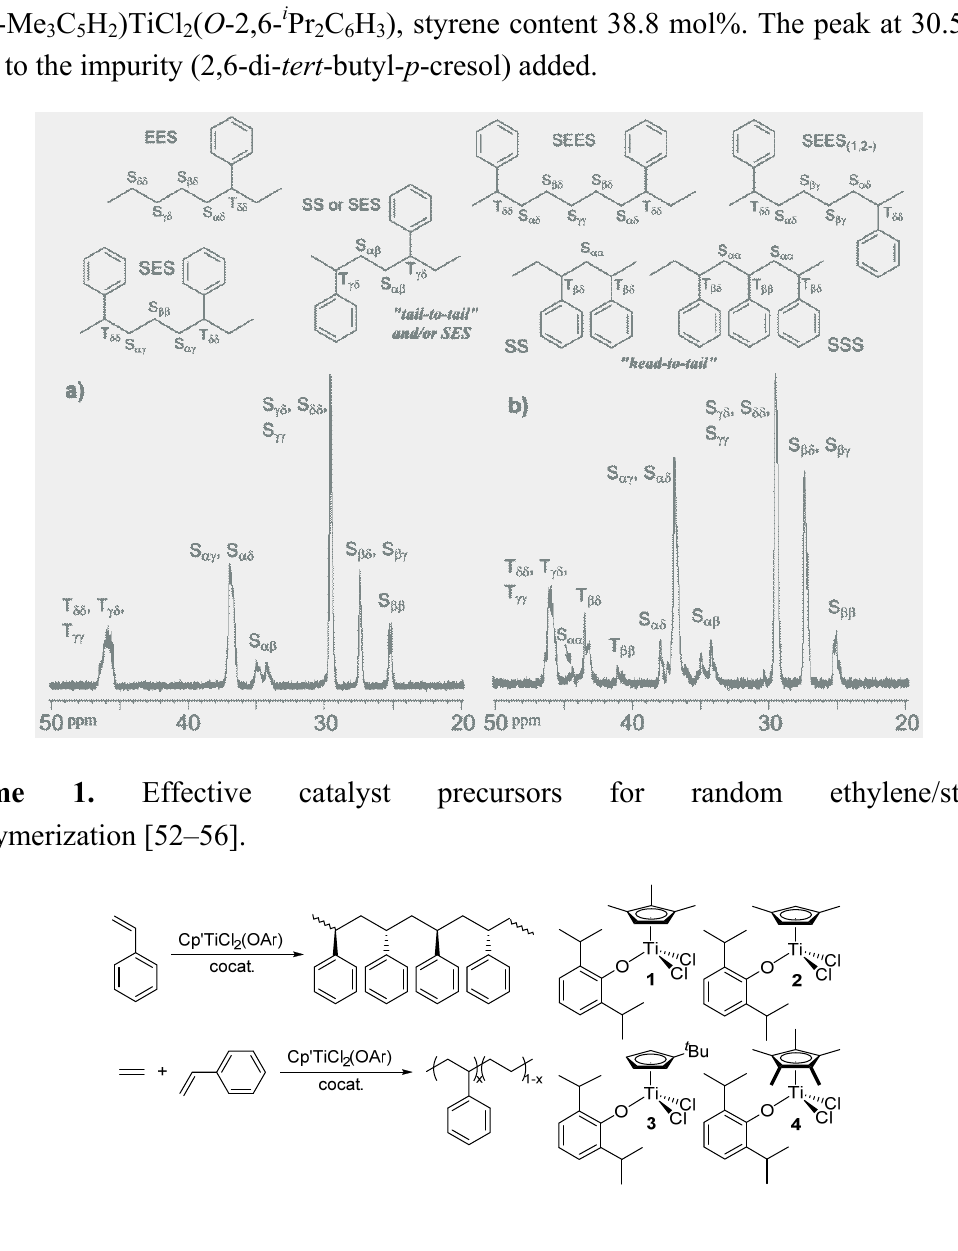
Figure 1. 13 C NMR spectra (in CDCl at 60 °C) of poly(ethylene- co -styrene)s (methylene 3 and methine region, tetrahydrofuran (THF) soluble fraction) [53]. Si(C Me )(N t Bu)]TiCl , styrene content 32.7 mol%; ( b ) catalyst = ( a ) catalyst = [Me 2 5 4 2 (1,2,3-Me C H )TiCl ( O -2,6- i Pr C H ), styrene content 38.8 mol%. The peak at 30.5 ppm 3 5 2 2 2 6 3